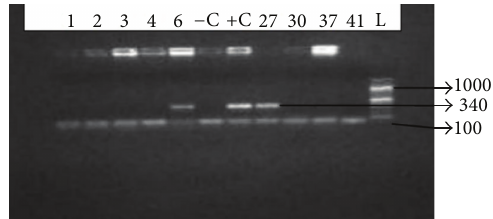
Figure 1: PCR for detection of HBV DNA in HBsAg negative patients. Representative agarose gel electrophoresis of PCR prod- ucts. Lanes 6 and 27 were positive for HBVDNA. Lanes 1, 2, 3, 4, 37, and 42 were negative for HBVDNA. +C: positive control, − C: negative control, and L: molecular weight size